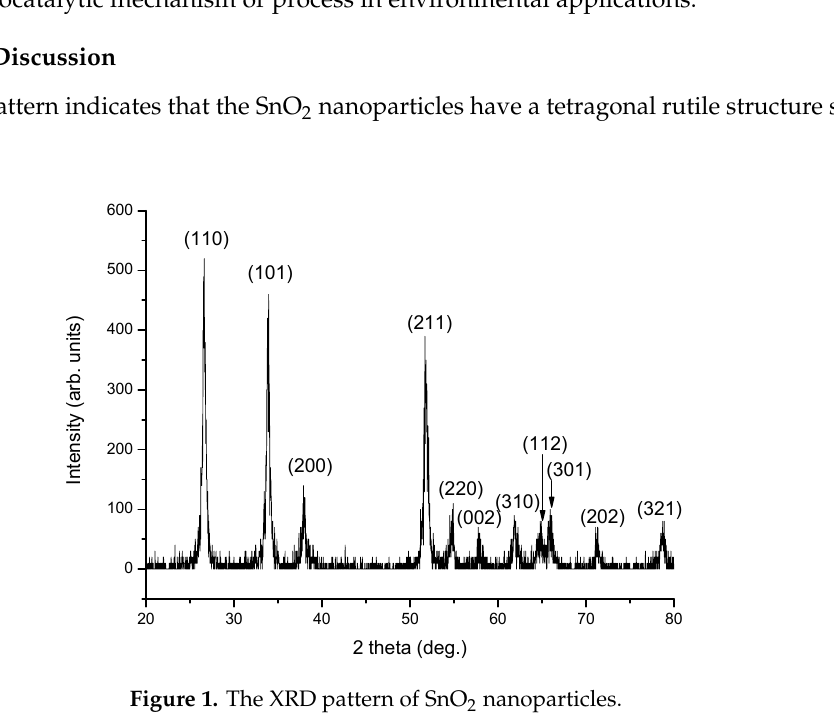
Figure 1. The XRD pattern of SnO 2 nanoparticles.